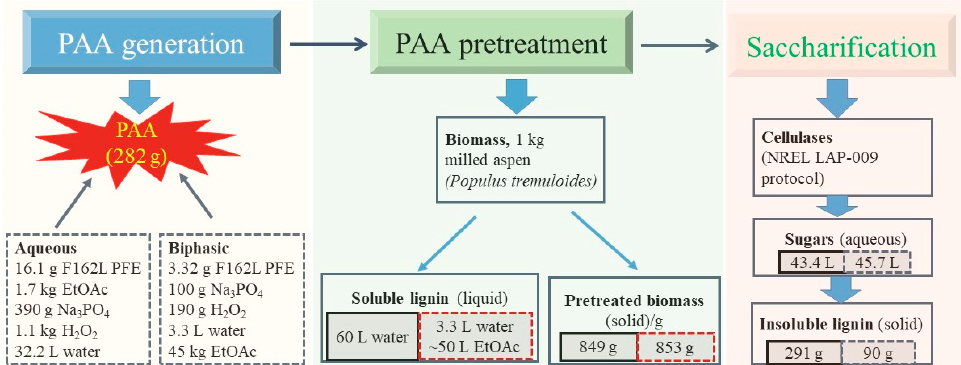
Figure 5. Mass balance with PAA pretreatment of milled poplar wood, including PAA formation, pretreatment and saccharification processes according to the data from reference